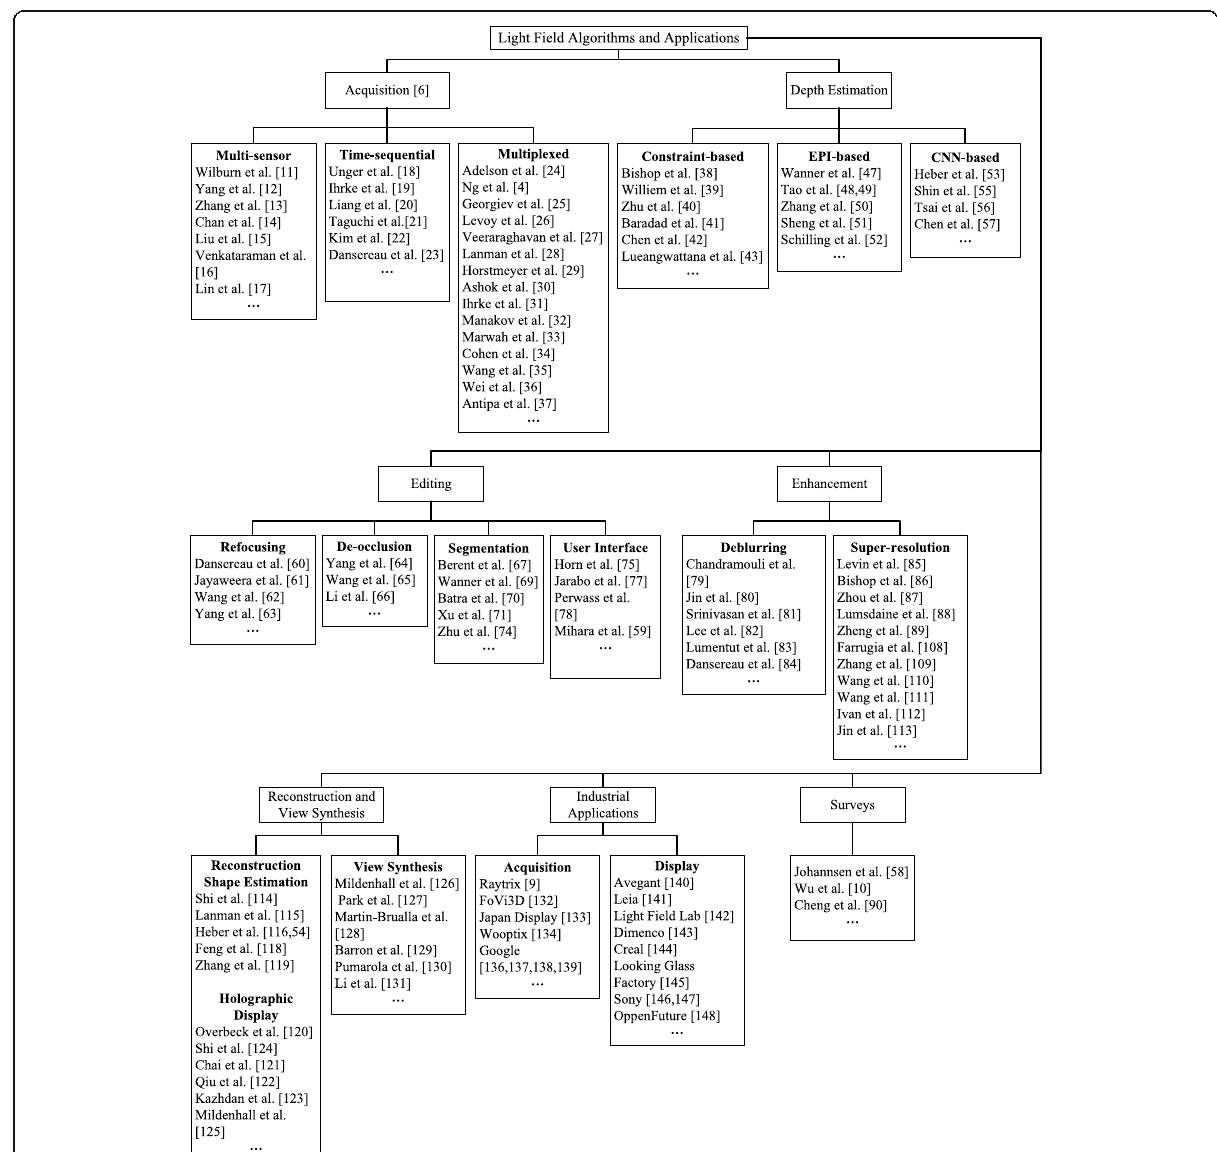
Fig. 4 Overview of light field algorithms and applications: the organization graph shows acquisition methods (Introduction Section), current depth estimation methods (Depth estimation Section), light field editing techniques (Editing Section), light field enhancements with an emphasis on increasing the quality of images (Enhancement Section), 3D reconstruction and view synthesis (Reconstruction and view synthesis Section), light field industry, which is categorized into light field acquisition and light field display (Industrial applications Section), and past surveys on light